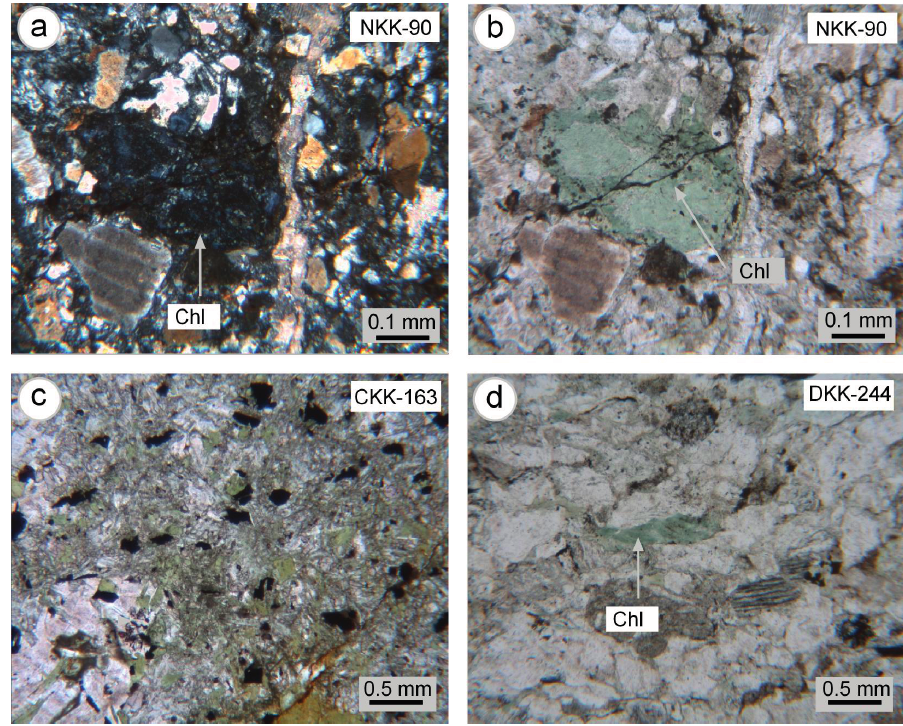
Figure 3. Optical microphotographs of chlorite and associated minerals from the Upper Karakaya Complex units (Chl = Chlorite, ppl = plane polarized light, cn = crossed polars); ( a ) Blue interference colored chlorite within the metasandstones of Orhanlar Unit (cp); ( b ) Green colored chlorite within the metasandstones of Orhanlar Unit (ppl); ( c ) Green colored chlorites within the metabasalts of Çal Unit (ppl); ( d ) Green colored